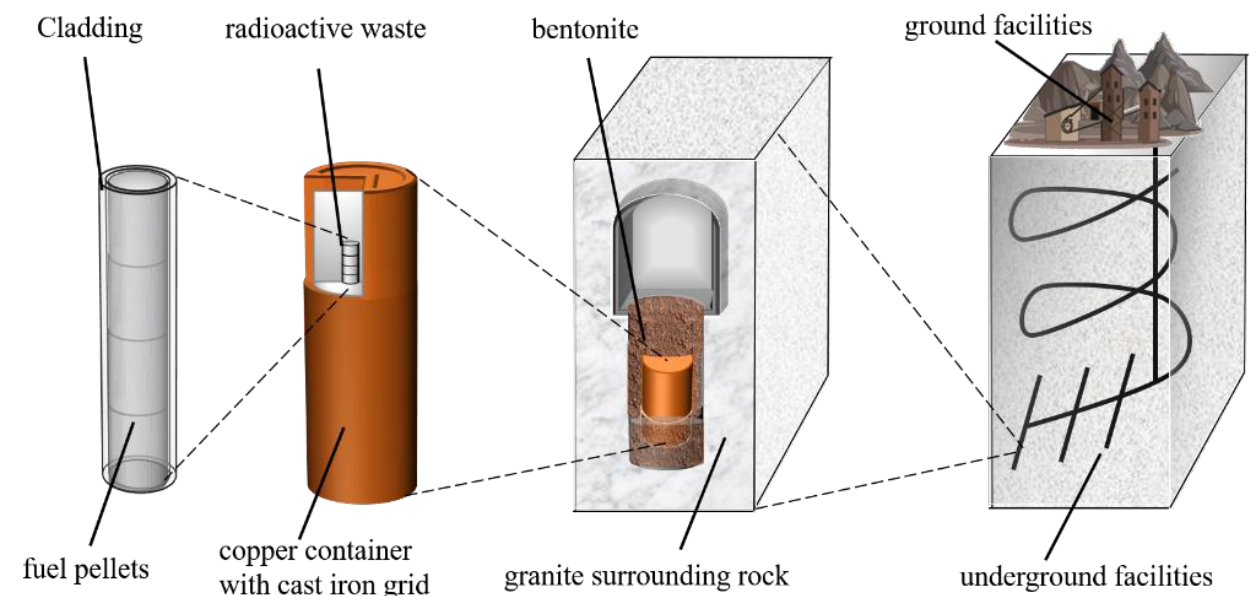
Figure 8. Model of underground radioactive waste disposal repository in China.